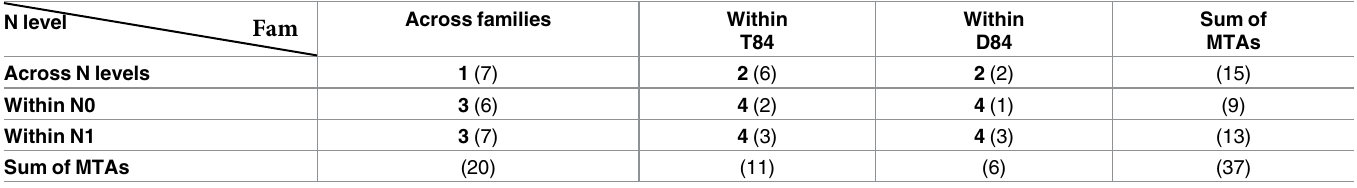
Table 1. List of four mixed models (1–4) applied to carry out marker-traitassociation (MTA) analysis, depending on N levels and families